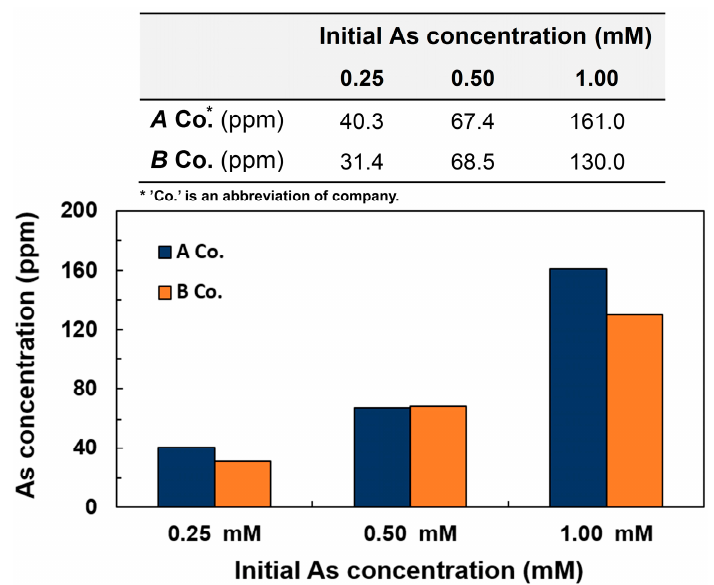
Figure 3. Concentration of arsenic absorbed on 25 g of coffee waste from wastewater depending on initial arsenic concentration at pH 7.